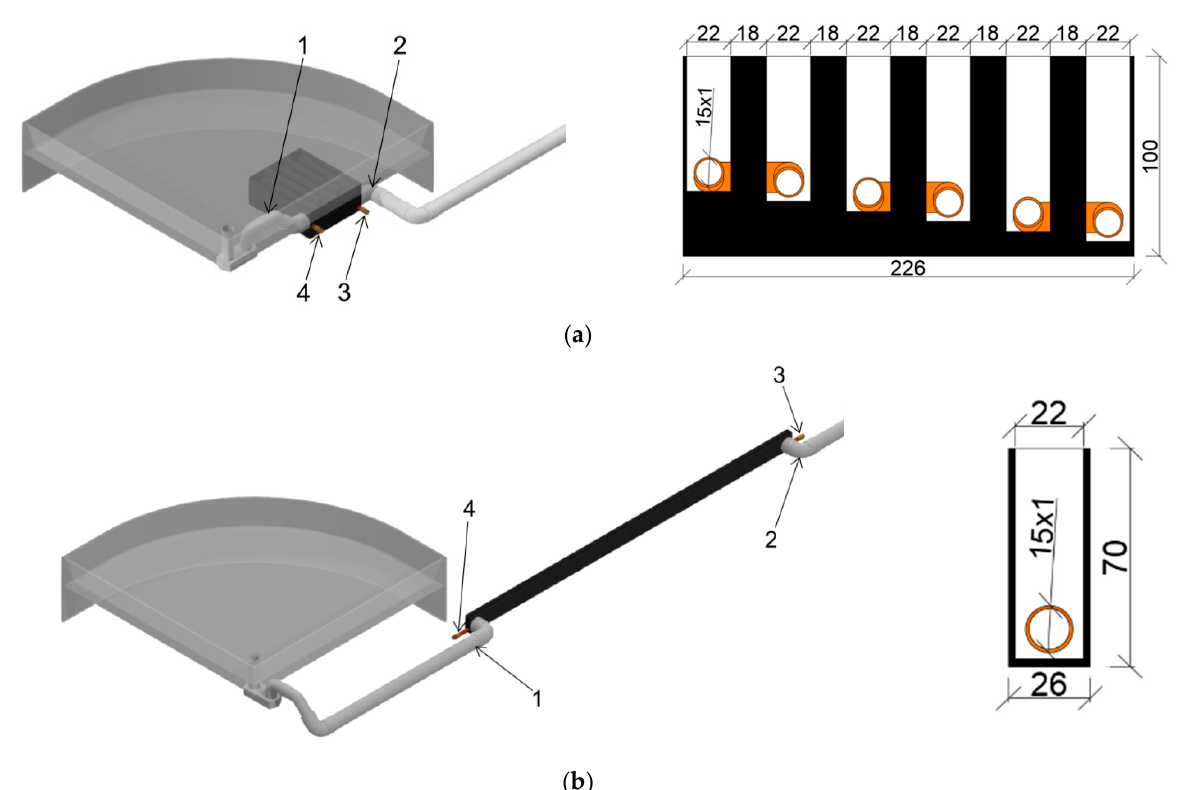
Figure 2. Location of the tested shower heat exchangers (1—drain water inlet; 2—drain water outlet; 3—cold water inlet; 4—preheated water outlet): ( a ) compact DWHR unit; ( b ) linear DWHR unit. The tests were performed according to the procedure shown in Figure 3.